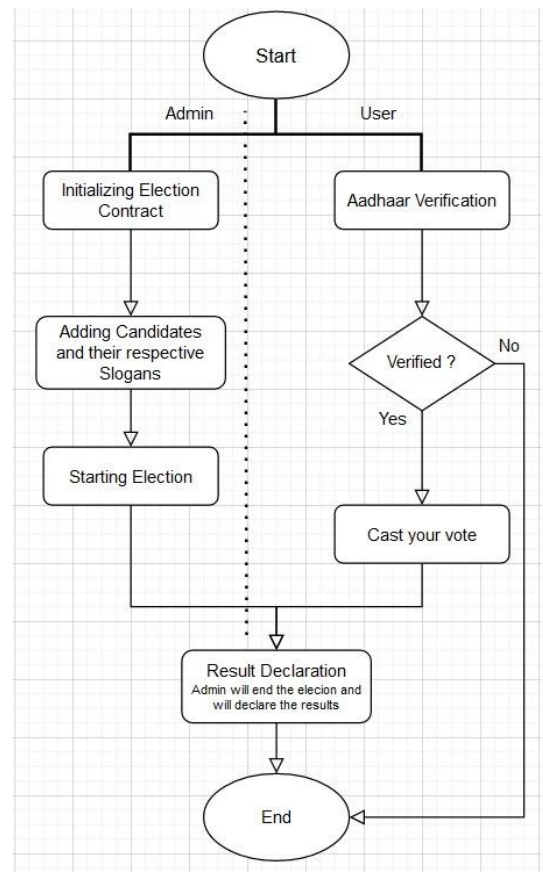
Fig 1 : flow chart of Election System using